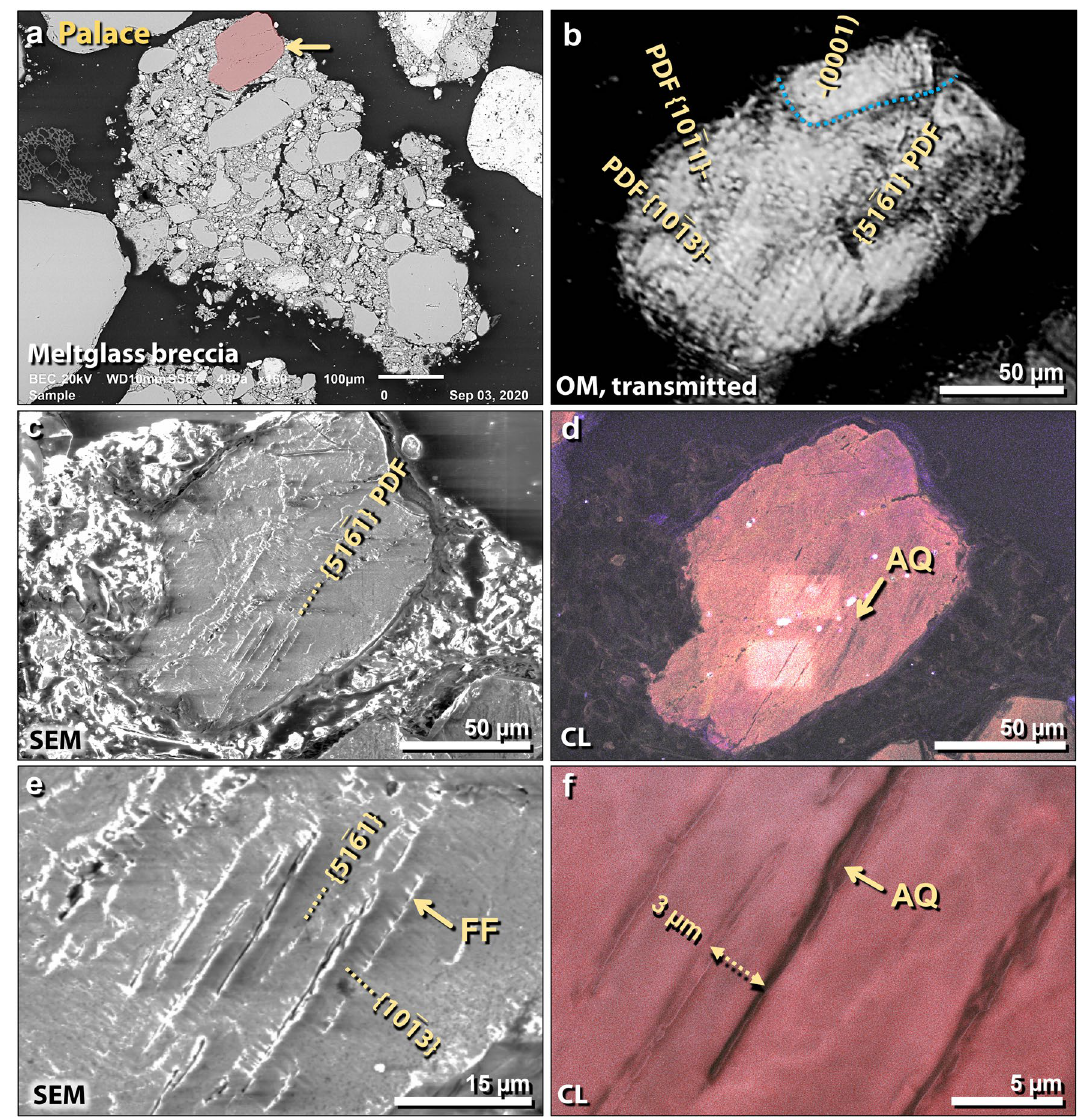
Figure 18. Shocked quartz grain from TeH palace. ( a ) SEM image of a 750-µm-wide fragment of meltglass breccia from the palace, containing melted and partially melted grains surrounded by Ca–Al–Si meltglass. Shocked quartz grain in red at arrow; other grains are not shocked. ( b ) Transmitted light photomicrograph using an optical microscope (OM); 155-µm-wide HF-etched quartz grain is same as in panel ‘ a ’. Lamellae are labeled as Miller-Bravais indices (hkil) (ANIE program 55 ). Three sets in lower crystallite are all closely-spaced PDFs crossing the entire crystallite. Blue dotted line marks the boundary of one crystallite in polycrystalline grain, containing only one set of lamellae, the (0001) plane with its pole parallel to the c axis. ( c ) SEM image of same HF-etched grain displaying visible lamellae, which excludes them as tectonic lamellae. ( d ) SEM-CL image of same grain showing multiple closely-spaced non-luminescent lamellae (black), indicative of amorphous quartz (AQ). ( e ) Close-up SEM image of same grain, showing visible lamellae, all of which display short-range feather features (FF) that form at ≥ 7 GPa. ( f ) SEM-CL close-up image, showing black non-luminescent centers of lamellae, indicative of amorphous quartz. Lamellar spacing is ~ 3–5